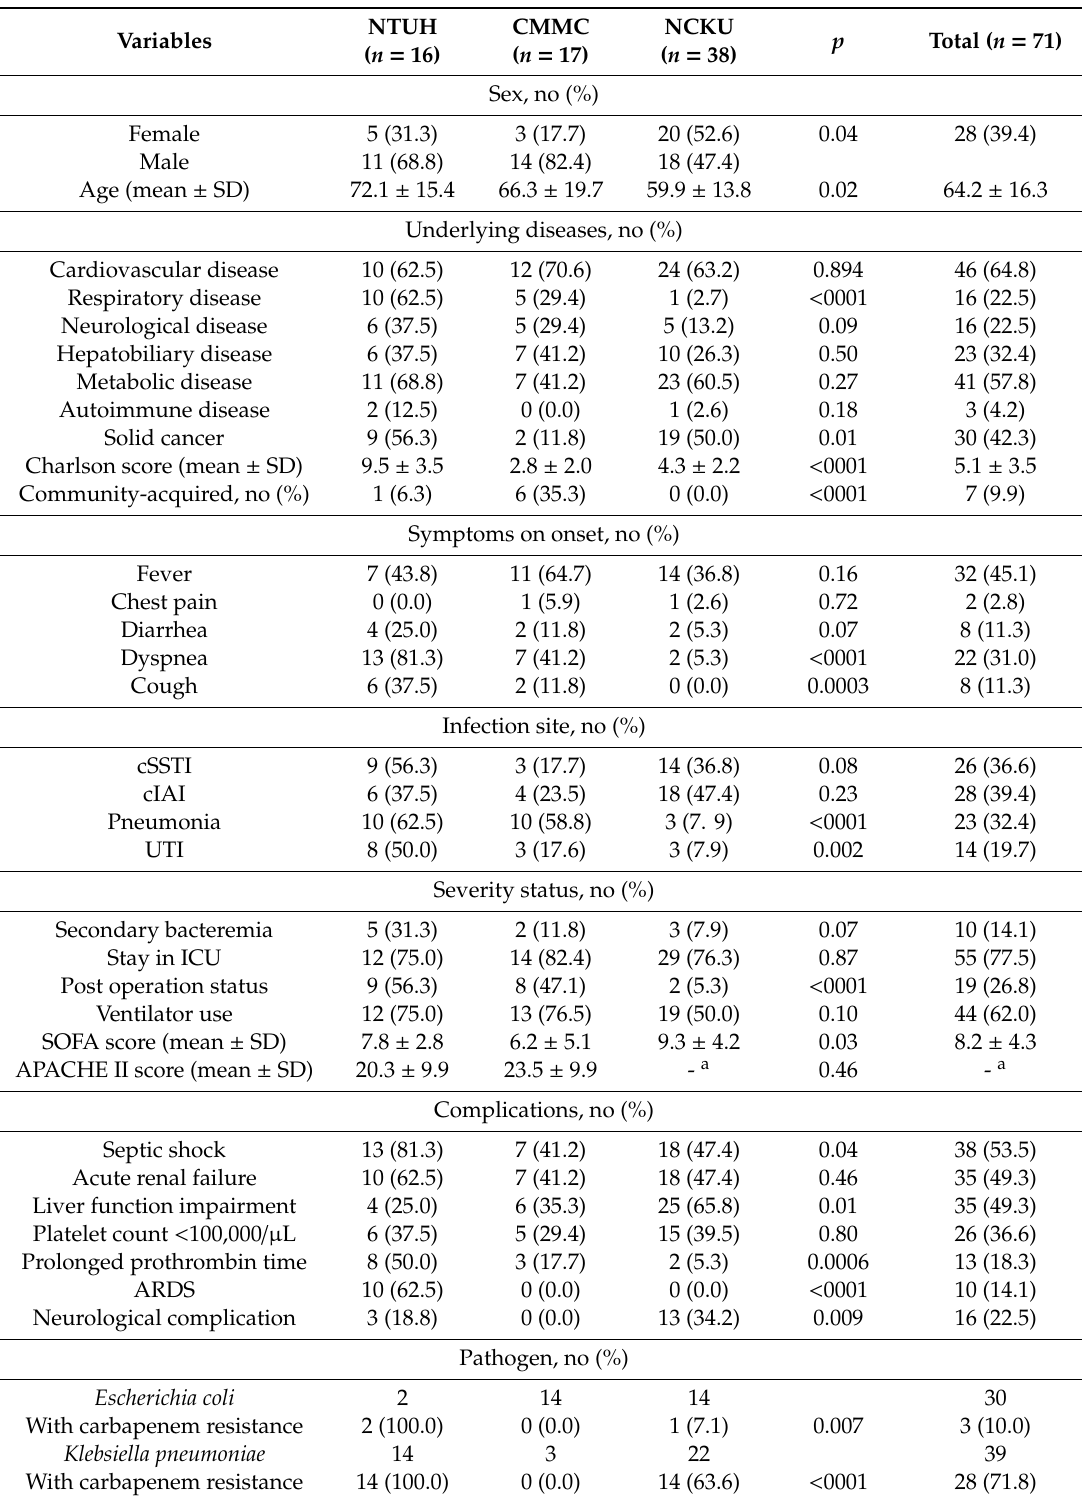
Table 1. Demographic data, comorbidity, symptoms, infectious status, pathogens, and outcome of the patients who received tigecycline-based therapy for ESBL-producing Enterobacteriaceae with or without carbapenem resistance in 3 medical centers in